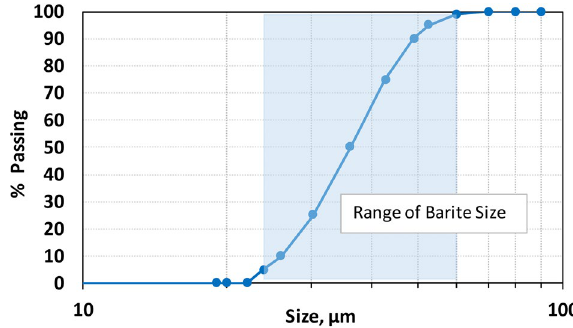
Figure 1. Particle size distribution of barite weighting agent.